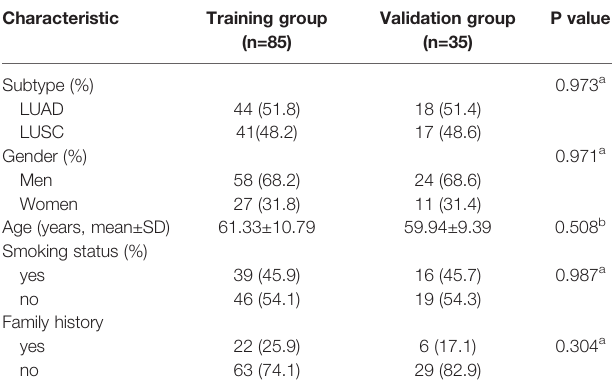
TABLE 1 | Demographic differences in the training and validation